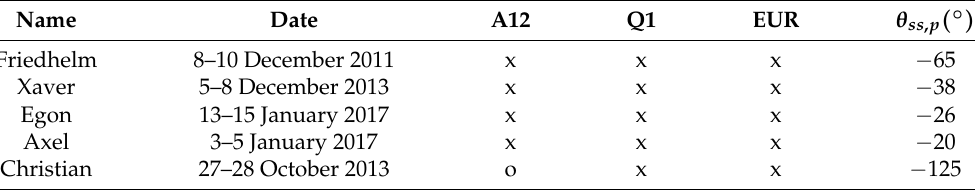
Figure 7. ( A , C , E ) Storm averaged sea-swell wave height centered around the peak of the storm at A12, Q1 and EUR, respectively. ( B , D , F ) Storm-averaged IG total (blue), free (black) and bound (red) IG wave heights at A12, Q1 and EUR, respectively. Table 2. Named storms included (x) or excluded due to data unavailability (o) in estimating the storm-averaged temporal IG response at the three stations. Mean sea-swell wave direction at the peak of the storm at A12 is given by θ ss , p using the nautical